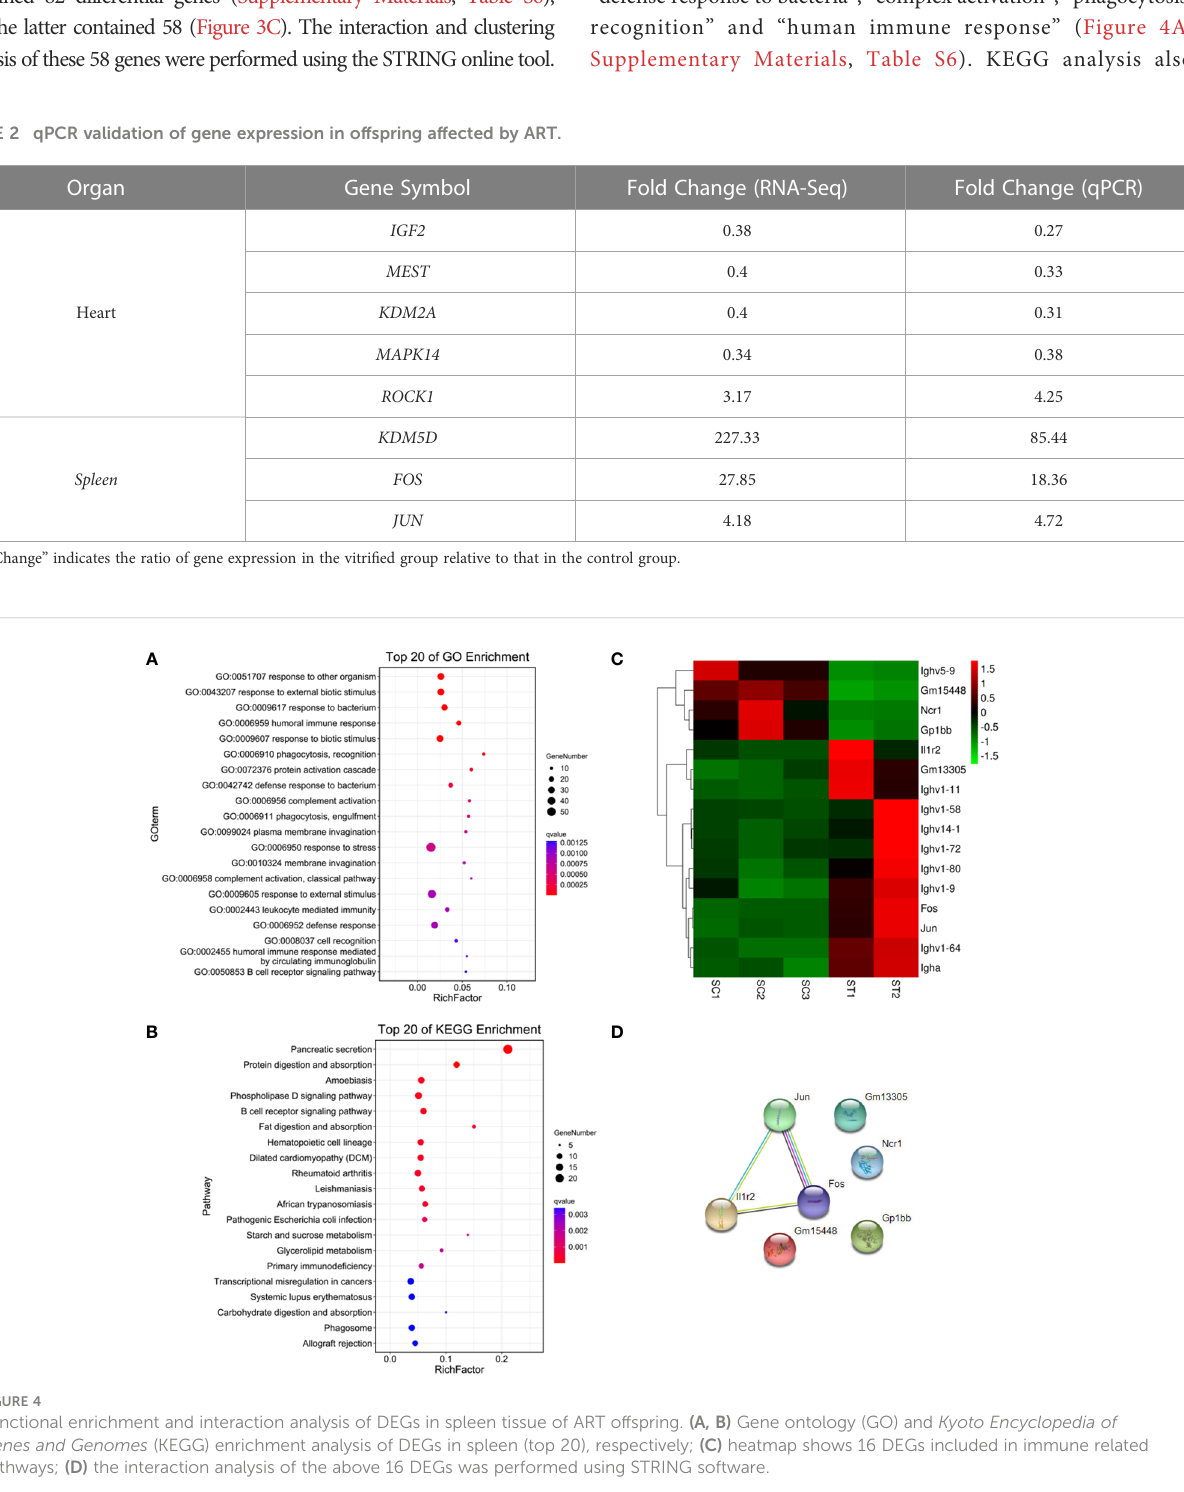
(Figure 3D). qPCR veri fi ed the differential expression of Rock1 and Mapk14 (Table 2).